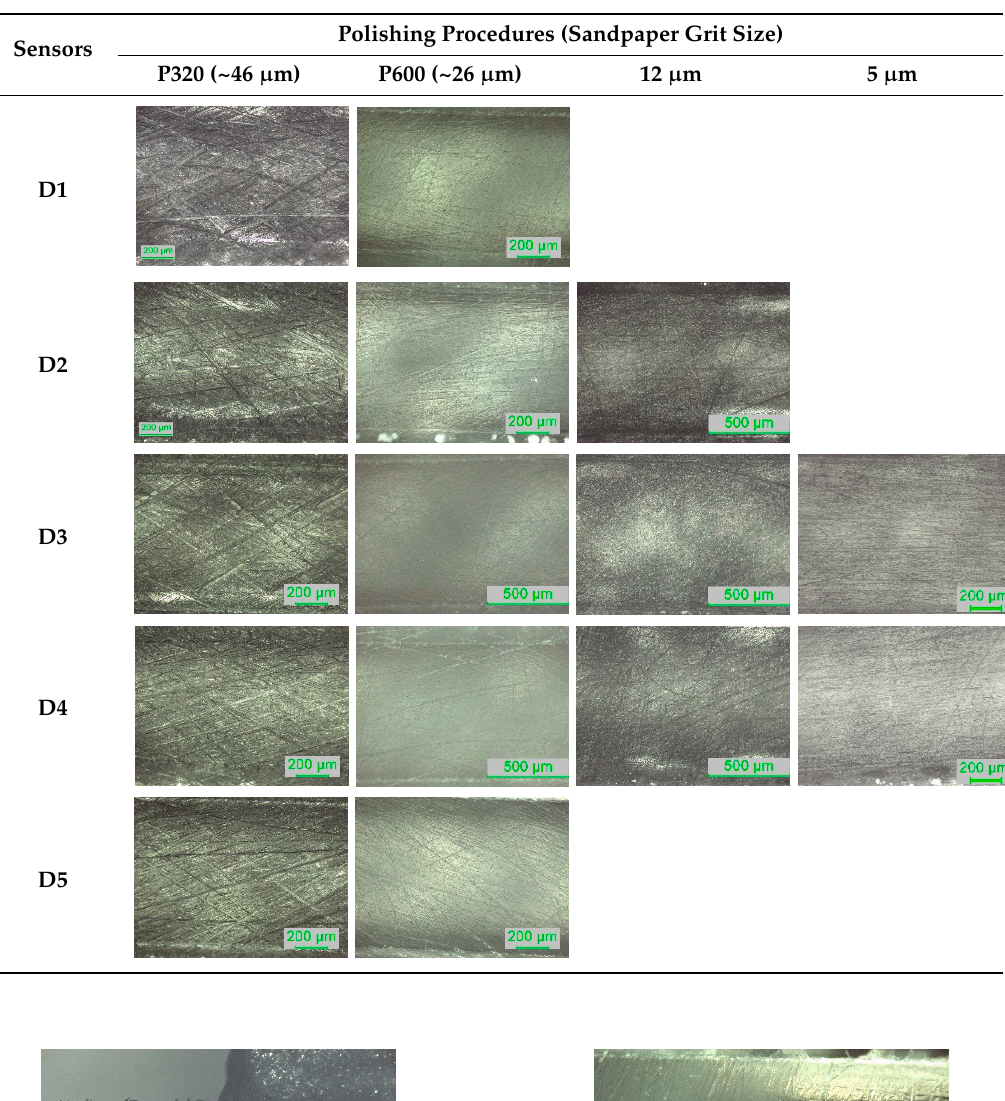
Table 2. D-shaped POF sensors: optical microscopy images of the sensing region after each polishing procedure (in reflection, with a 10× objective lens).